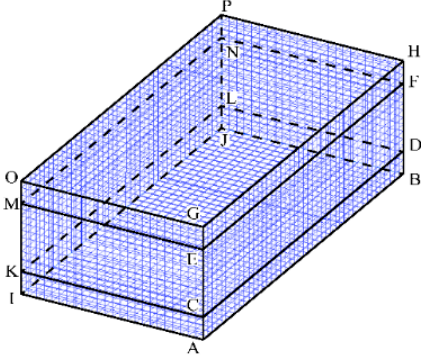
Figure 5. Computational domain for VPPAW model.